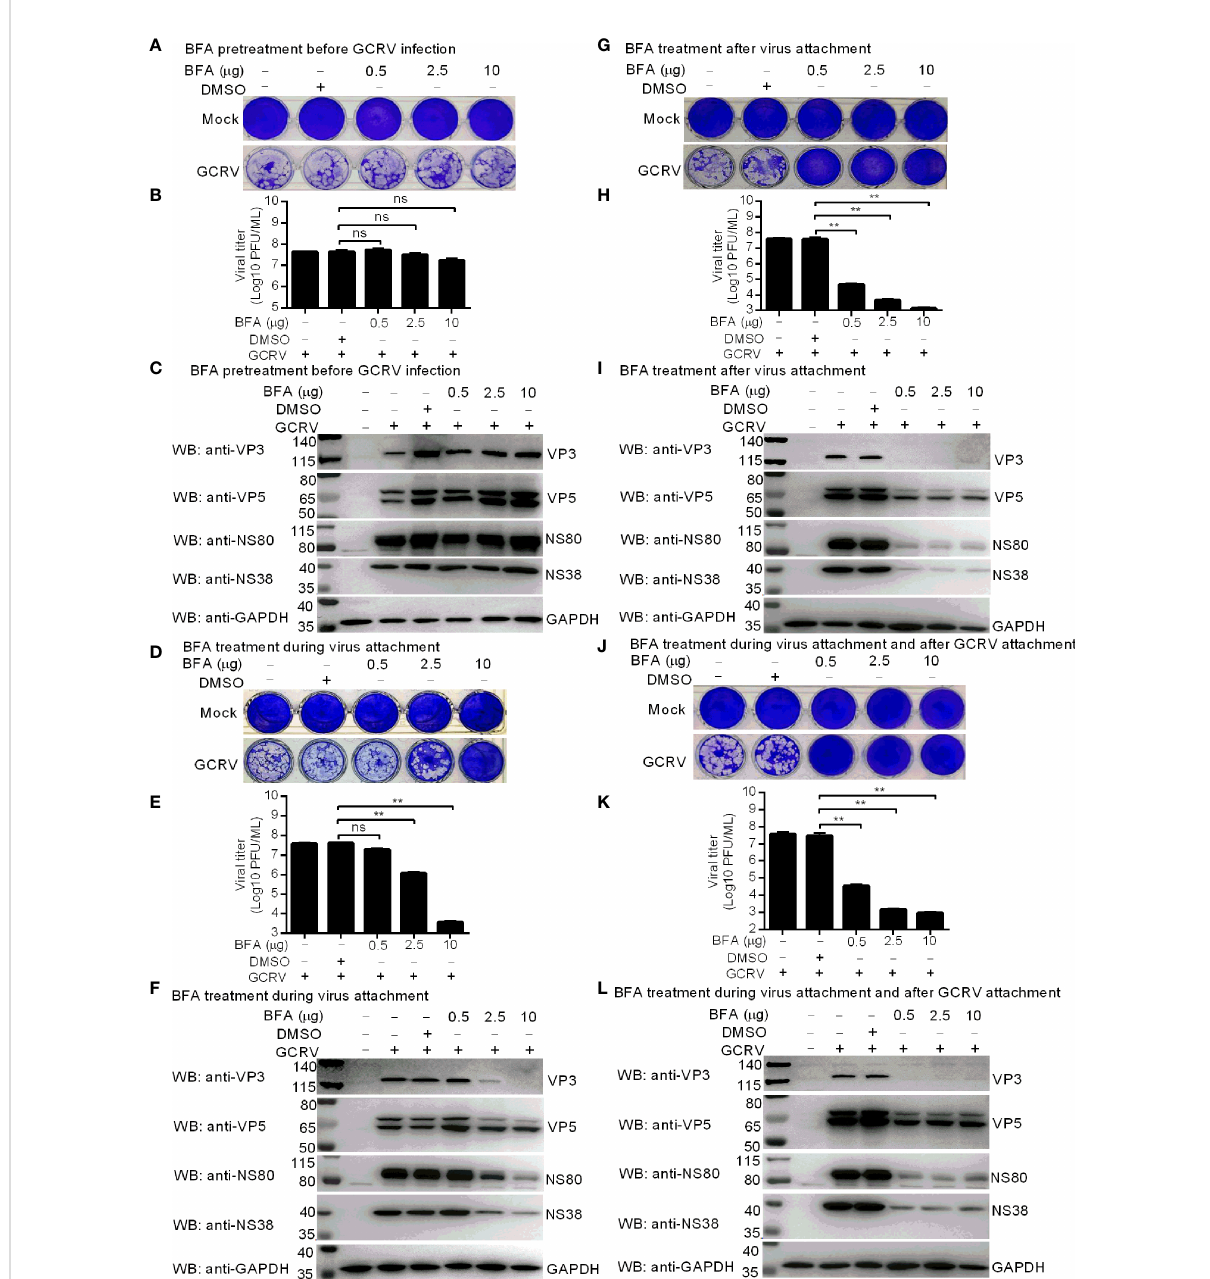
FIGURE 3 Inhibition of gcARF1 activation by BFA impairs GCRV replication and infection. (A – C) BFA pretreatment before GCRV infection has no in fl uence on GCRV replication and infection. CIK cells plated in a 24-well or 6-well plates were incubated with BFA using the indicate concentrations or equivalent volume of DMSO for 1 h or left untreated. (D-F) BFA treatment during virus attachment suppressed GCRV replication and infection. CIK cells plated in a 24-well or 6-well plates were infected with GCRV and treated with BFA using the indicate concentrations or equivalent volume of DMSO for 1 h or left untreated. Then, the cells were washed with PBS to remove BFA and non-adsorbed virions. (G – I) BFA treatment after virus attachment suppressed GCRV replication and infection. CIK cells were infected with GCRV for 1 h, then washed with PBS to remove non-adsorbed virions, and fi nally treated with BFA using the indicate concentrations or equivalent volume of DMSO for another 24 h or left untreated. (J – L) BFA treatment during virus attachment and after virus attachment suppressed GCRV replication and infection. CIK cells were infected with GCRV and treated with BFA for 1 h, then washed with PBS to remove BFA and non-adsorbed virions, and fi nally treated with BFA for another 24 h. The cells in the 24-well plates were used for crystal violet staining (A, D, G, J) , the culture supernatants of infected cells used for determination of GCRV titers (B, E, H, K) , and the cells in the 6-well plates used for protein extraction (C, F, I, L) . Means ± SEM (n=3) are shown in (B, E, H, K) . Data were tested for statistical signi fi cance. The asterisk above the bracket indicated statistical signi fi cance between the two groups connected by the bracket. ** p < 0.01; ns, not signi fi